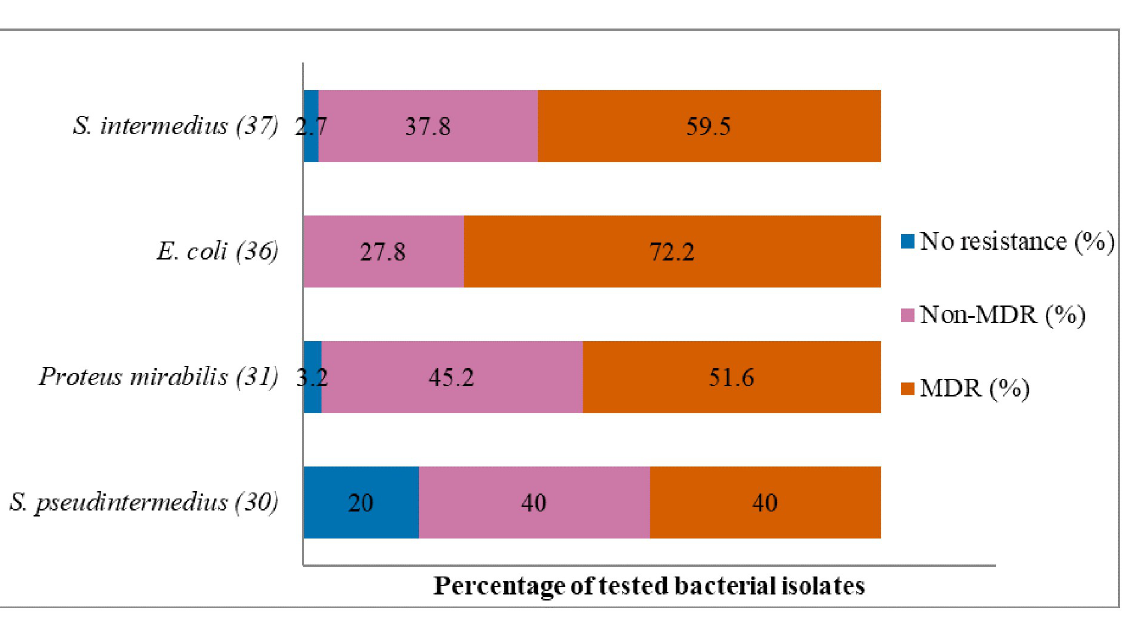
Fig 11. Multidrug resistance of clinically important bacterial pathogens from diseased dogs between 2015 and 2017. Numbers inside brackets ‘()’ indicate number of isolates detected; those on bars indicate percentages per organism; Non-MDR–Resistant to 1 or 2 classes; MDR–multi-drug resistant, resistant to 3 or more classes.